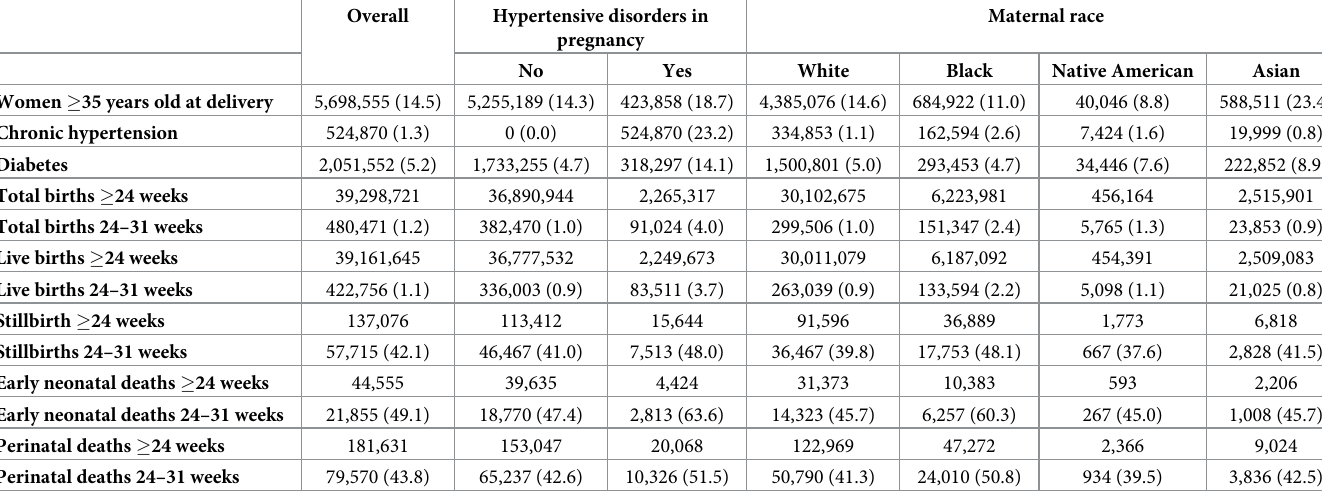
Table 1. Numbers of singleton births and perinatal deaths (excluding congenital and chromosomal anomalies), in the United States, 2006–2015. Overall Hypertensive disorders in